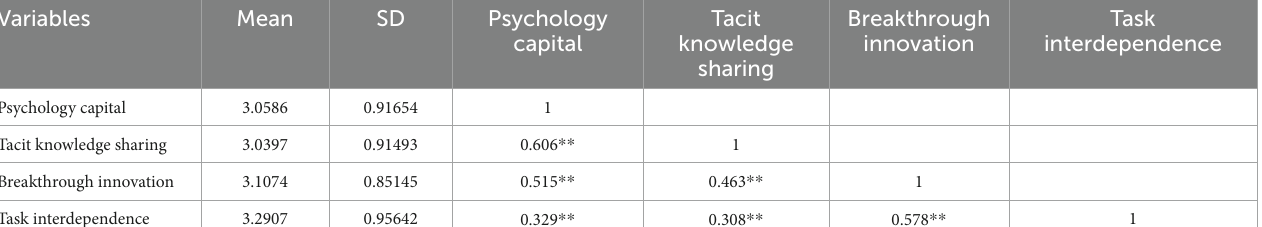
TABLE 2 Descriptive statistics and correlation analysis.